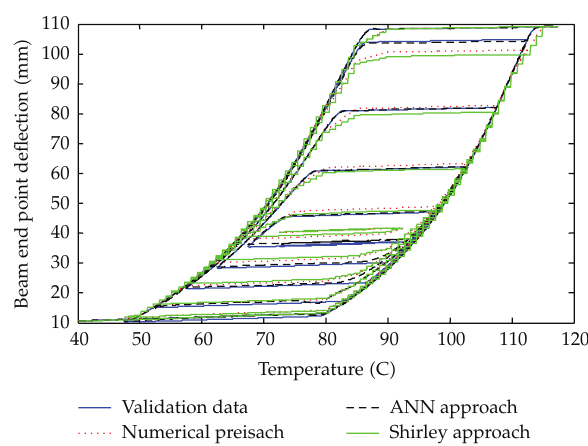
Figure 21: Prediction of the hysteresis behavior for classical numerical Preisach model, proposed ANN model, and Shirley approach in comparison to the second damped experimental data set.